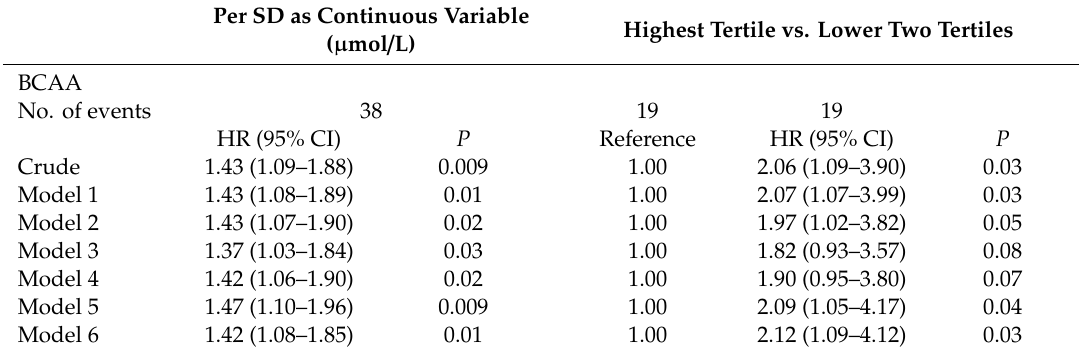
Table 3. Association of plasma BCAAs with post-transplant diabetes mellitus in renal transplant recipients ( n = 386).